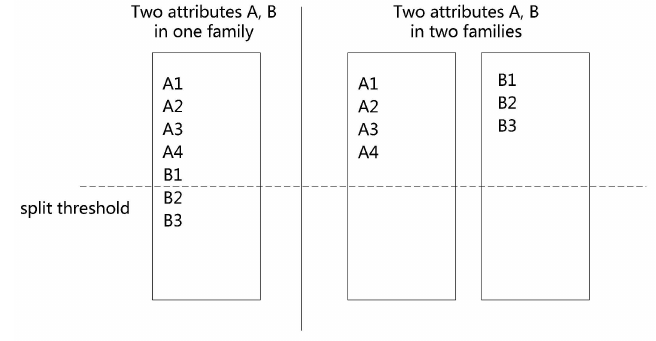
Figure 5. Effect of vertical partitioning on region